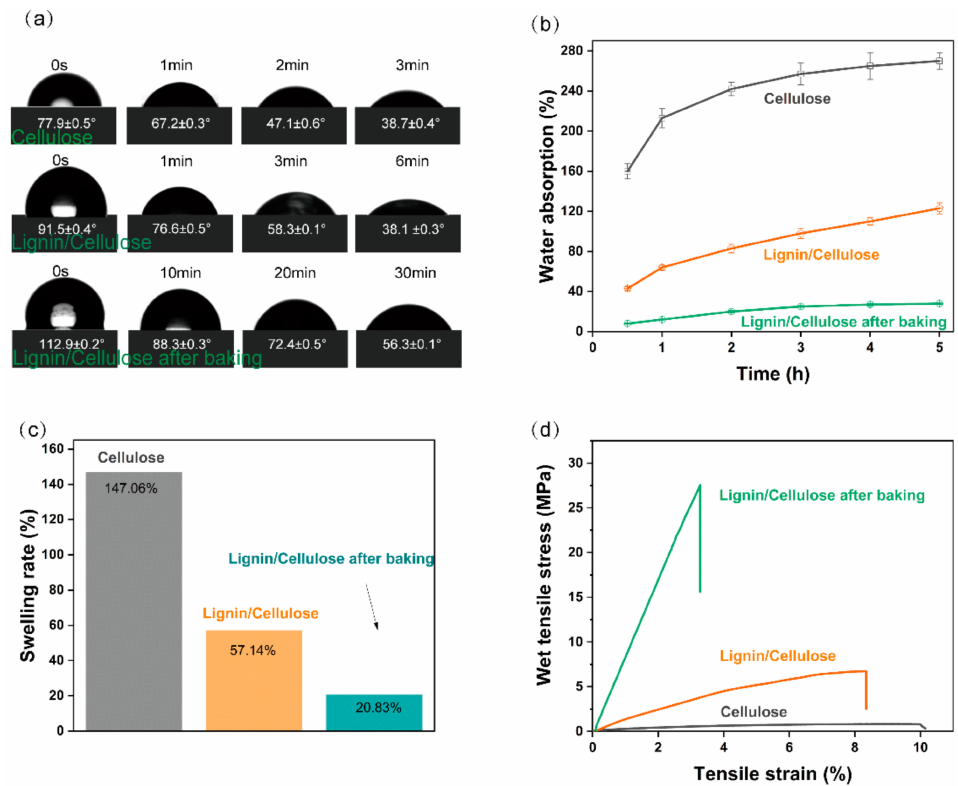
Figure 5. ( a ) Contact angle of the sheets; ( b ) time-dependent change in the water absorption ratios of the sheets; ( c ) thickness-growth percentage of the sheets; ( d ) wet tensile strength of the